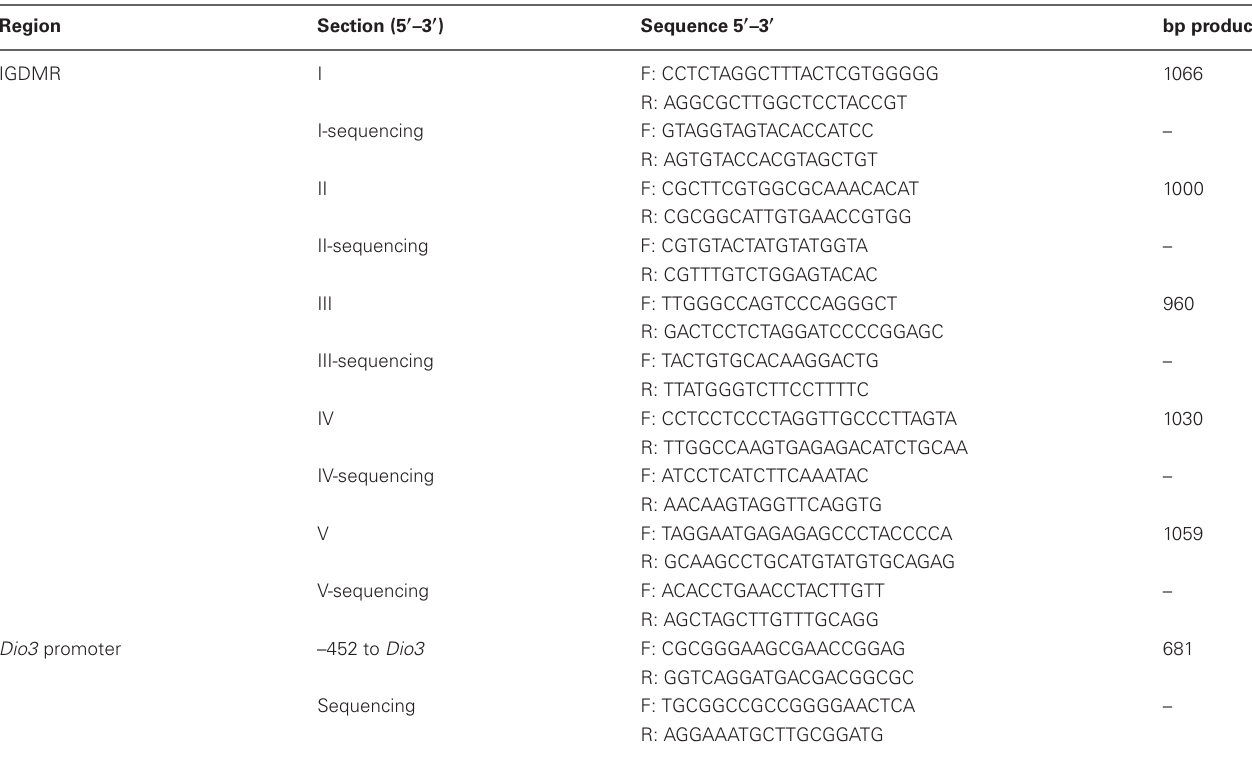
Table 1 | PCR and sequencing primers for IGDMR and Dio3 promoter.